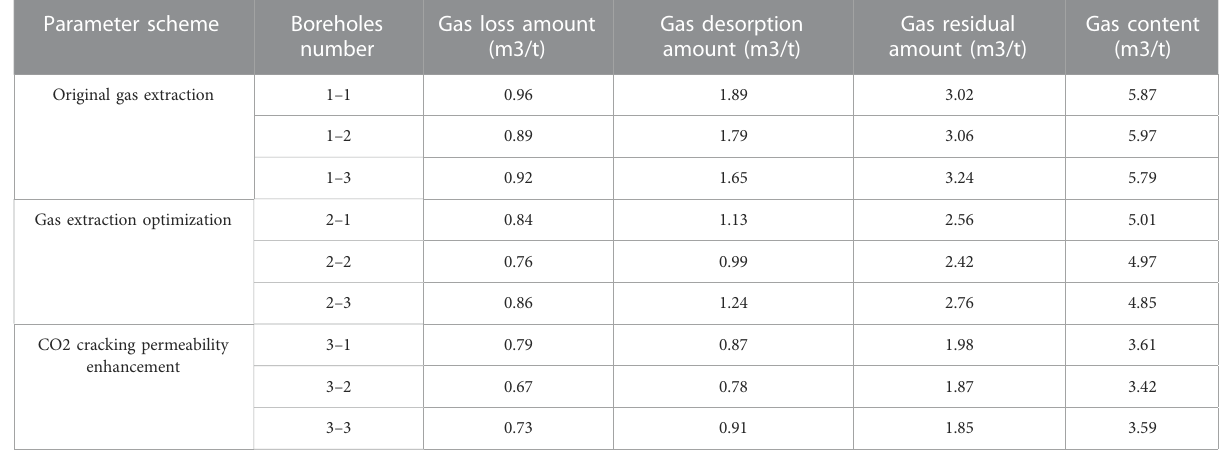
TABLE 4 Working face gas content determination.